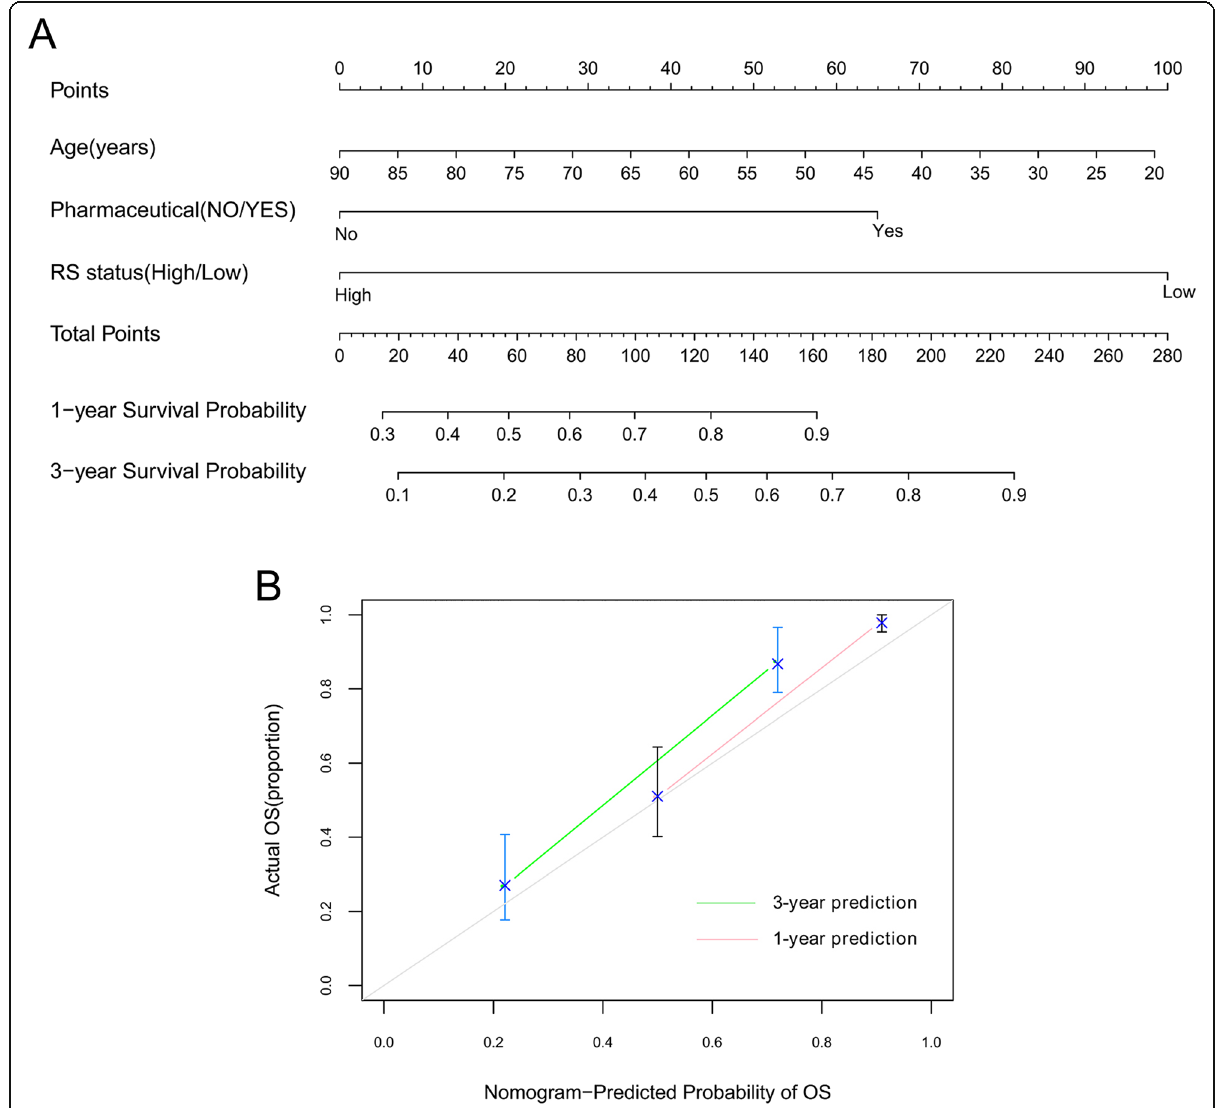
Fig. 5 A nomogram incorporating risk score based on expression levels of eight mRNAs, age and pharmaceutical therapy for predicting survival of GBM patients. a , the sum of points for each variable value is located on Total Point axis, and used to determine likelihood of 1-year and 3-year overall survival of each individual patient. b , calibration plots of nomogram for predicting 1-year and 3-year overall